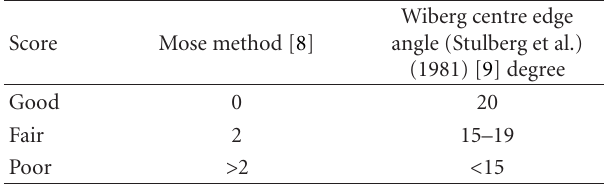
Table 1: Reported assessment methods used to categorise severity of LCPD